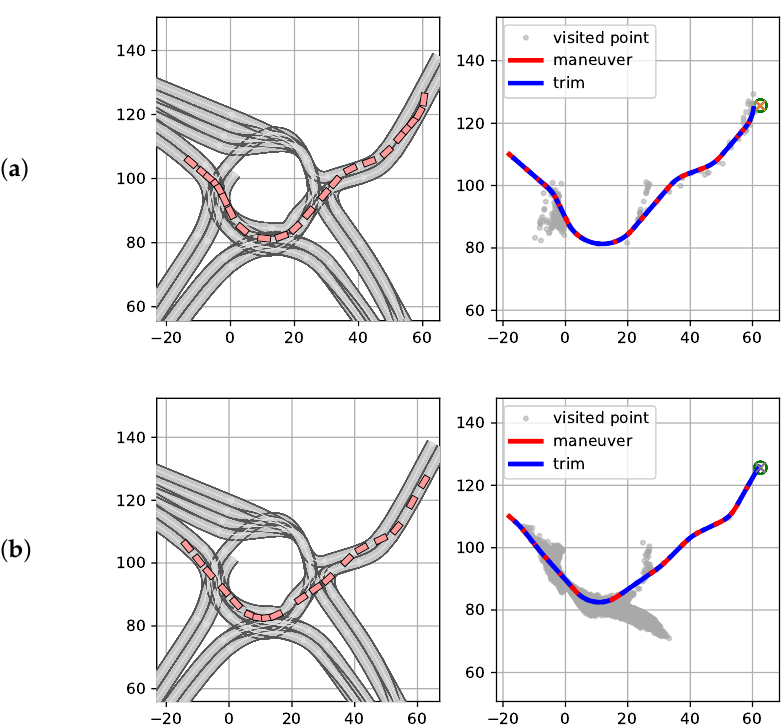
Figure 15. Trajectories for the automaton with 31 trims: ( a ) handcrafted; ( b ) extracted.